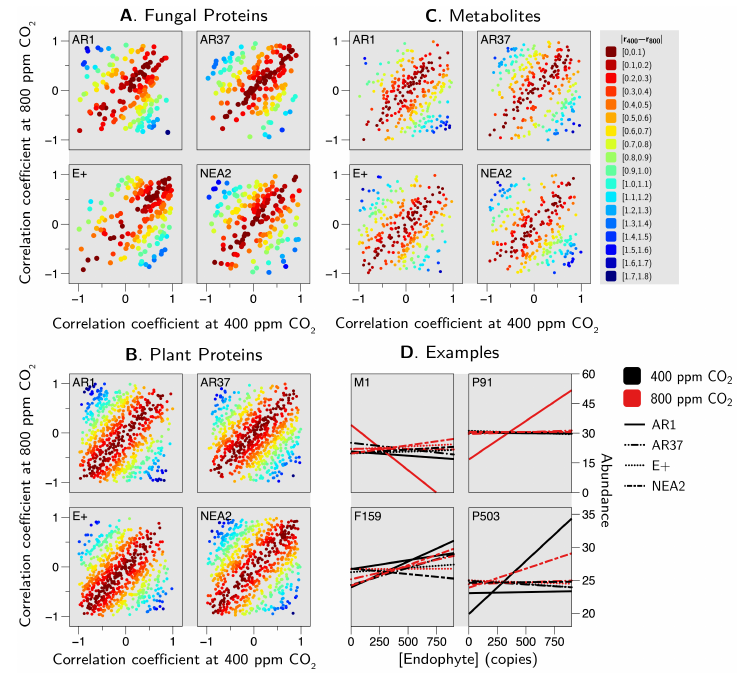
Figure 9. Correlations with Epichloë concentration. Show are the correlation coefficients ( r ) and the individual proteins ( A , B ) and metabolites ( C ) separated by epichoid strain (note that the points for the fungal proteins are larger for ease of viewing). Furthermore, ( D ) examples of the relationships between epichloid strain and four compounds (M1 ≡ “metabolite 1”, P91 ≡ “plant protein 91”, F159 ≡ “fungal protein 159”, P503 ≡ “plant protein 503” are shown; see Supplementary Tables S1 and S2) that are highly correlated ( r > 0.99) with at least one of the epichloid strain by CO 2 combinations. Black lines represent 400 ppm CO 2 , red lines denote 800 ppm CO 2 ; the different line types denote different ephichloid strains, but their identities are not important here. Here it suffices to note that the pattern of responses tends to be “strain specific” rather than general across all